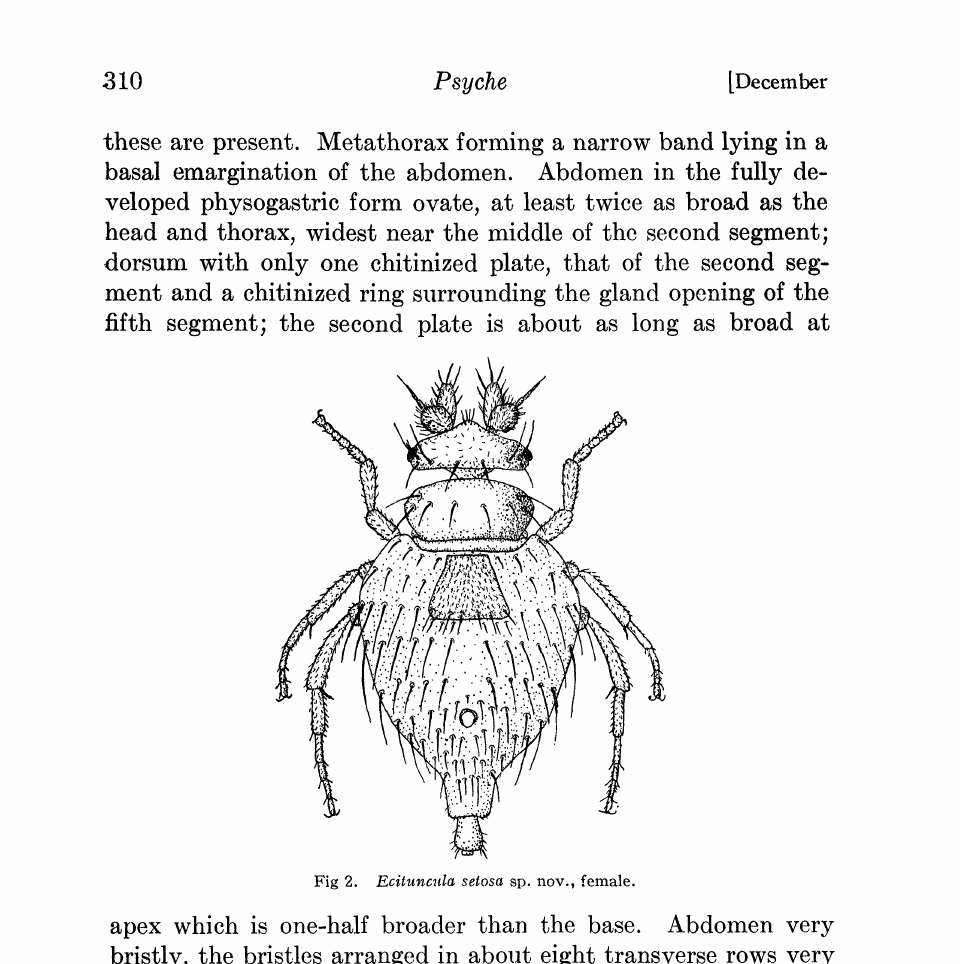
Fig 2. Ecincula seos s. nov.,